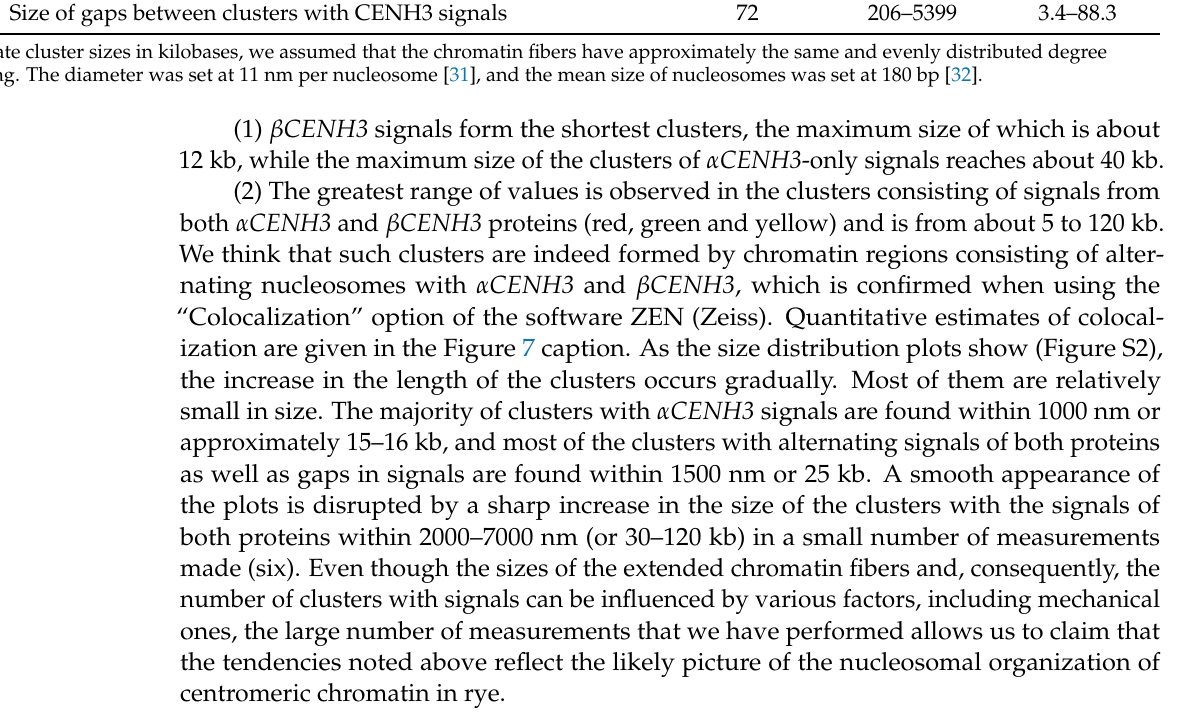
Clusters Size, nm Size, kb Measured